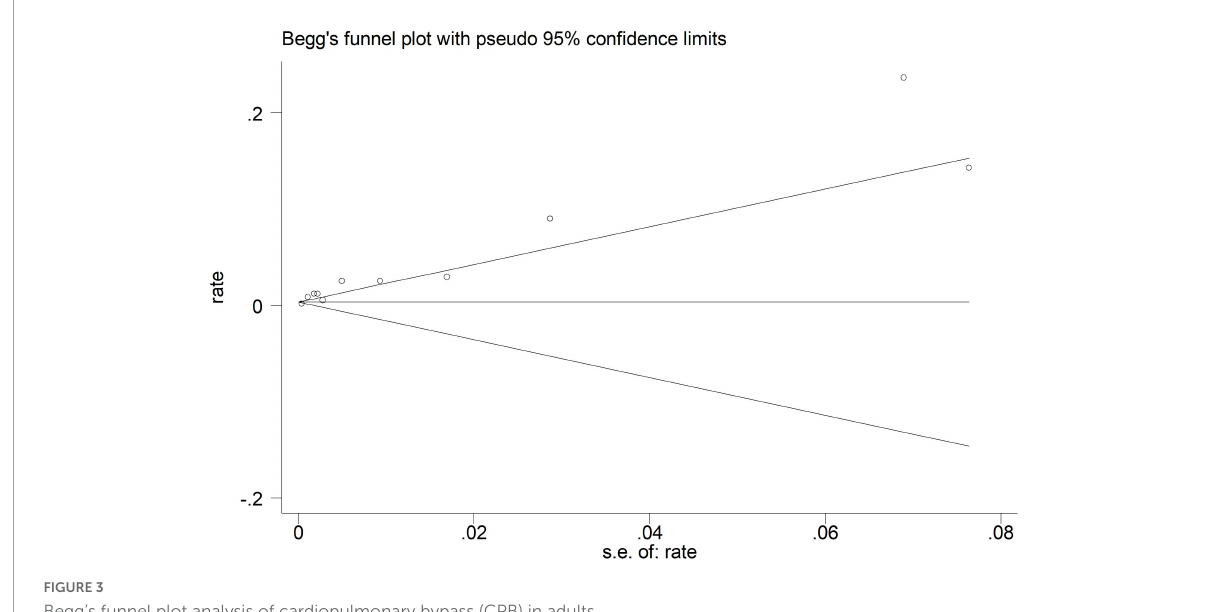
FIGURE3 Begg’s funnel plot analysis of cardiopulmonary bypass (CPB) in adults.